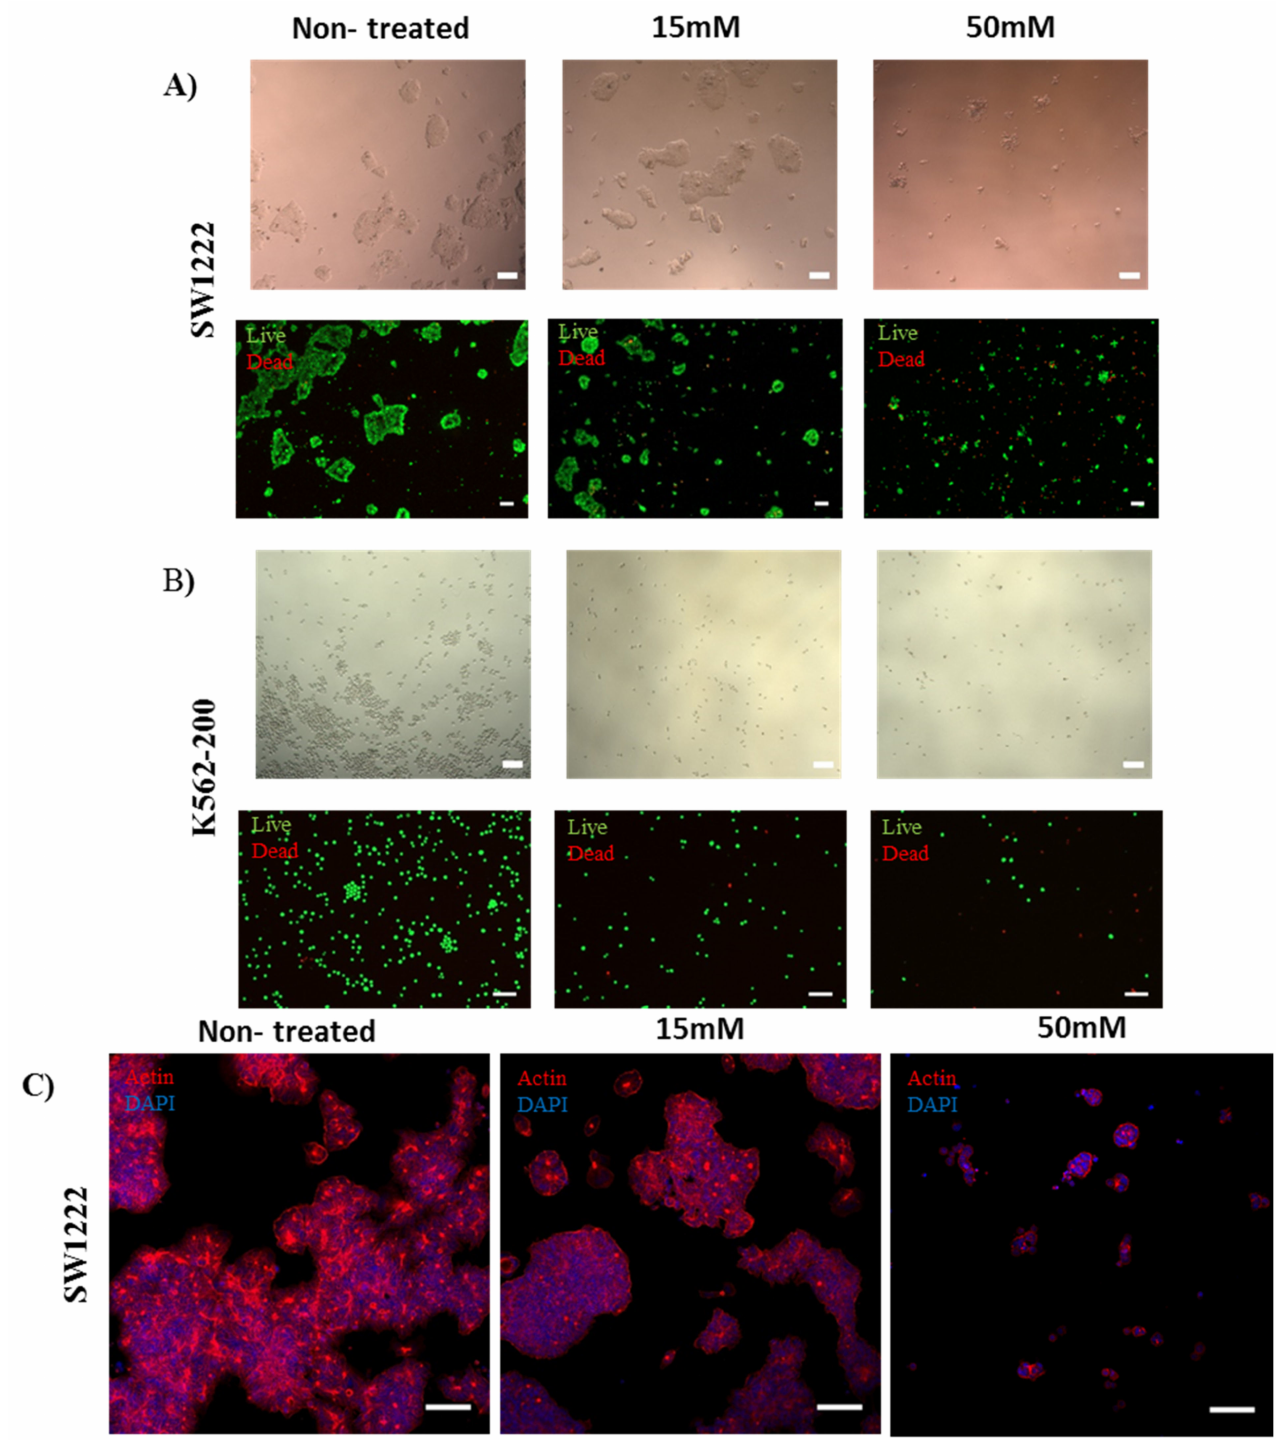
Figure 8. Effect of metformin on cell viability and actin fiber organization. (scale bar 100 µ m) ( A , B ) Bright field images of SW1222 and K562-200 (top), showing the appearance of apoptotic morphology in the presence of metformin at the selected concentrations. Live/dead staining of SW1222 and K562-200 (bottom), showing a concentration-dependent decrease in cell viability as the metformin concentration increases. ( C ) Confocal images showing the effect of metformin on actin fibers organization and cell morphology in SW1222. Cell shrinkage and rounding was observed with increasing concentrations of